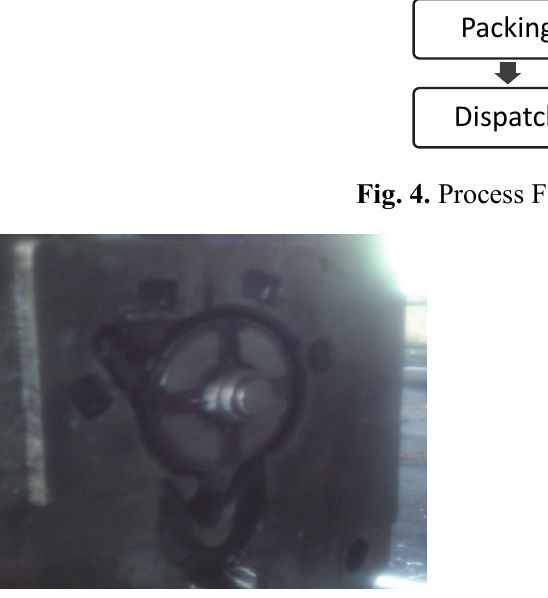
Fig. 5. Image of Die-Casting Operation